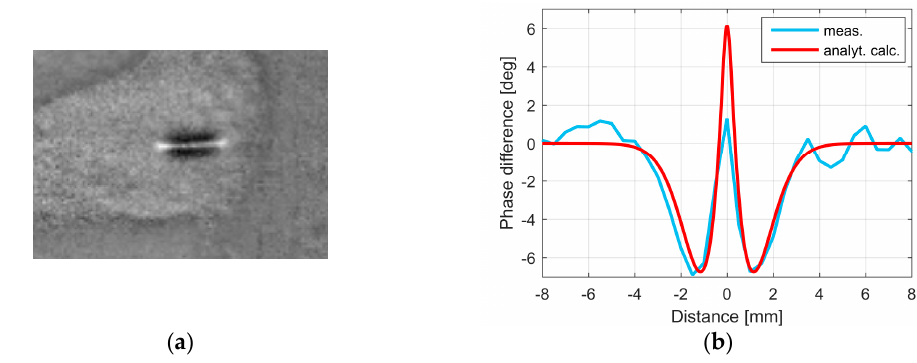
Figure 9. ( a ) Phase image of a 12 mm long crack after a 0.1 s heating pulse at a ground surface; ( b ) the measured phase profile compared with the calculated one for a 1 mm depth.